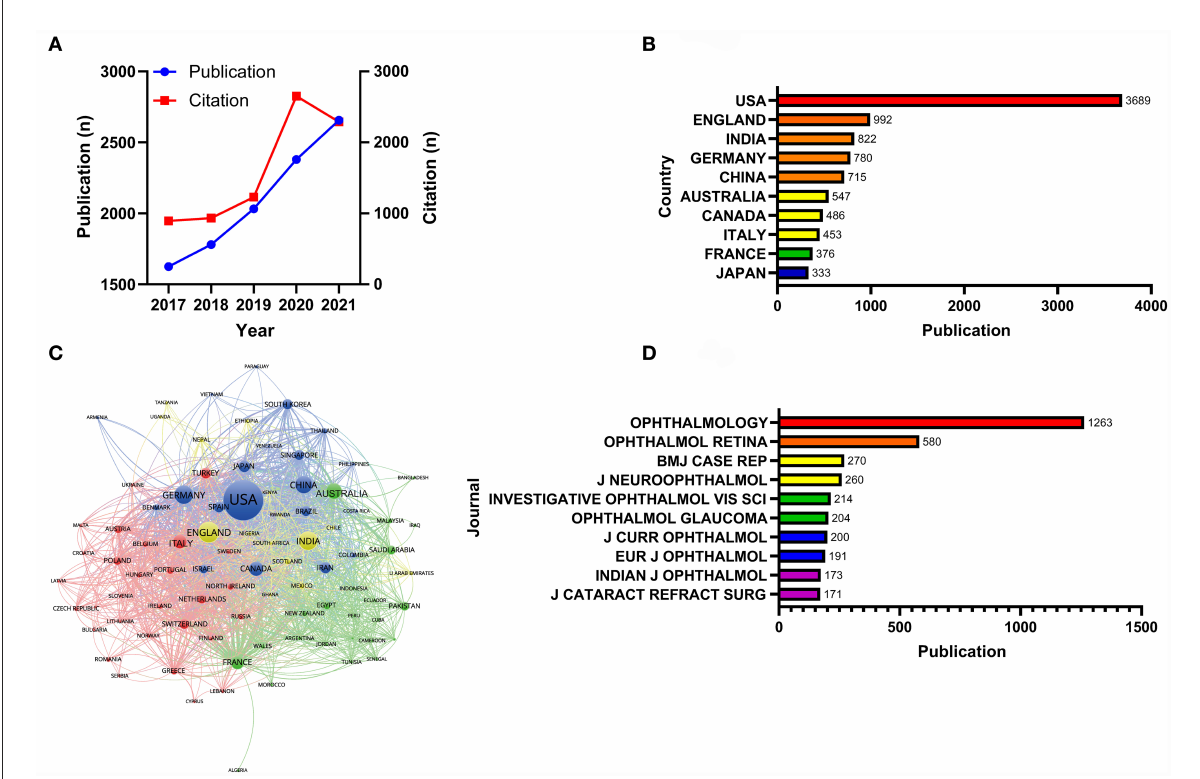
FIGURE1 Global distribution of research output. (A) Annual publications and citations of ophthalmology research from 2017 to 2021. (B) Top 10 countries in terms of total publications. (C) Country cooperation networks. (D) Top 10 journals by total publication volume of ophthalmology research in a 5-year